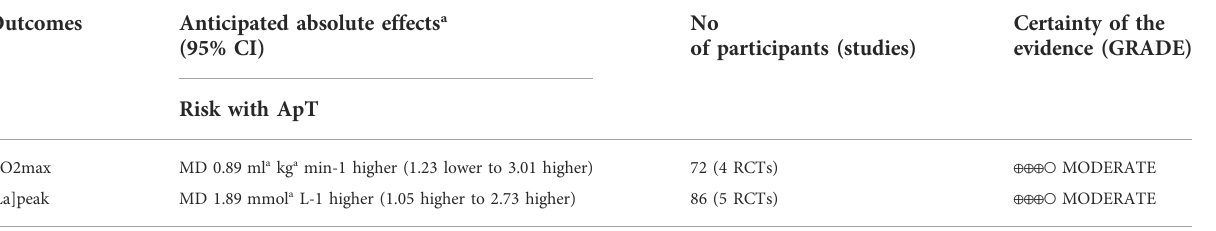
TABLE 1 Grading of Recommendations Assessment, Development, and Evaluation (GRADE) summary of fi nding.